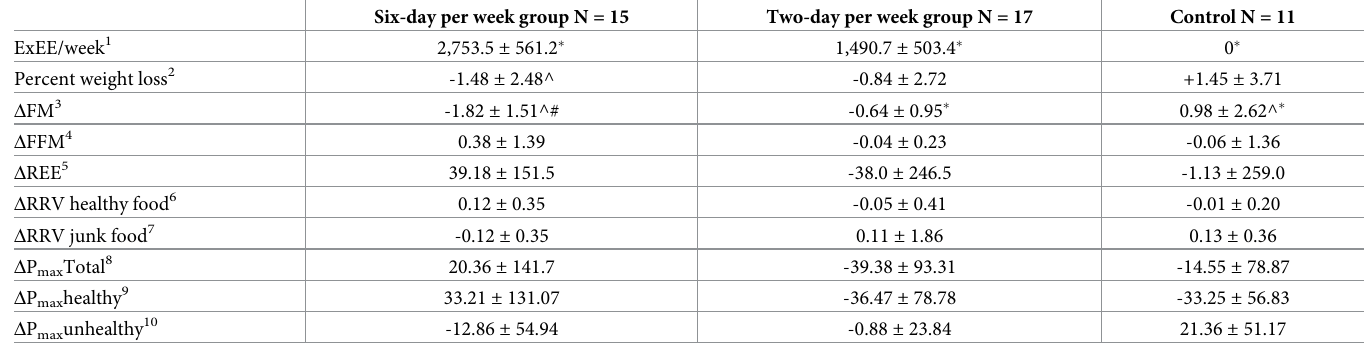
Data are mean ± SD � , ^: like letters indicate significant differences between groups, P � 0.05. #Significant change over time (change different from zero) P � 0.05. 1